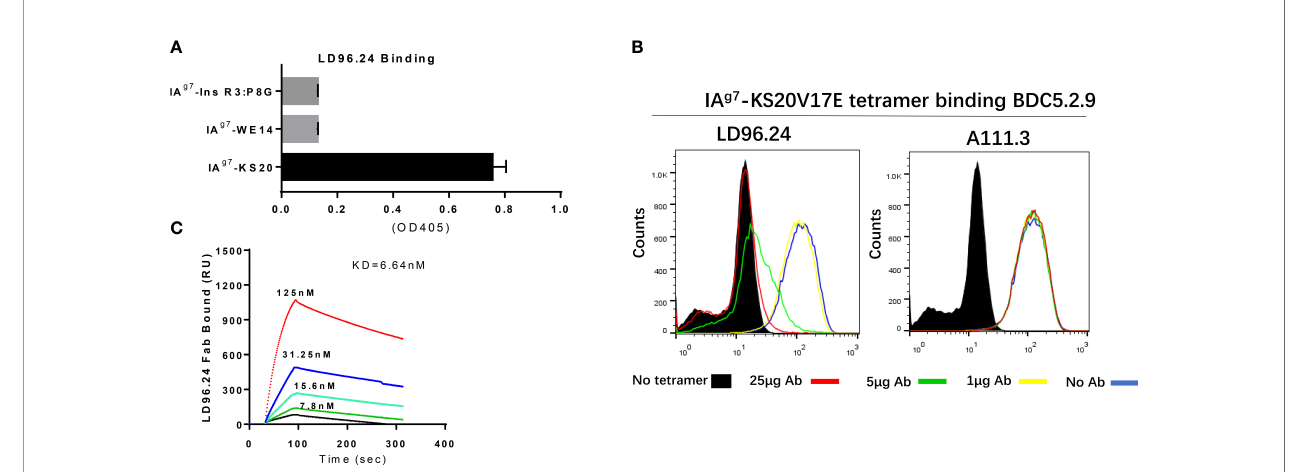
FIGURE 1 | LD96.24 speci fi cally binds on the IA g7 -KS20V17E complex. (A) ELISA plates were coated with various IA g7 -peptide complexes, including IA g7 – KS20V17E complexes and control complexes IA g7 -Ins R3:P8G and IA g7 -RLGL-WE14. The binding of LD96.24 to immobilized complexes was measured with ELISA. (B) T-cell hybridoma BDC5.2.9, which is speci fi c for IA g7 -KS20, is stained with IA g7 -KS20V17E tetramers in the presence or absence of LD96.24 or isotype antibody A111.3 and analyzed by fl ow cytometry. No tetramer or tetramer plus 0, 1, 5, or 25 m g LD96.24 or A111.3. (C) The binding kinetics of various concentrations of Fab fragments of LD96.24 to immobilized IA g7 -KS20V17E were recorded by using surface plasmon resonance, and IA g7 -RLGL-WE14 was used as